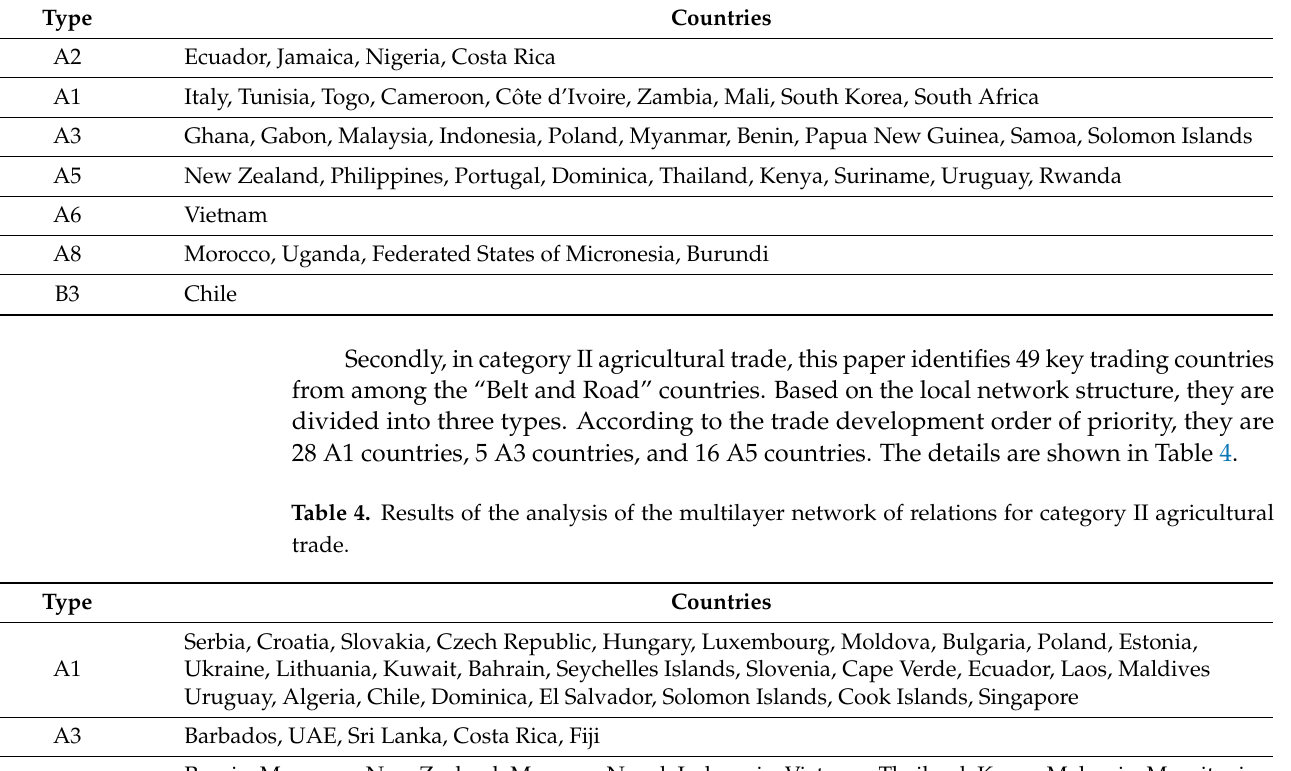
Table 3. Results of the analysis of the multilayer network of relations for category I agricultural trade. Type Countries